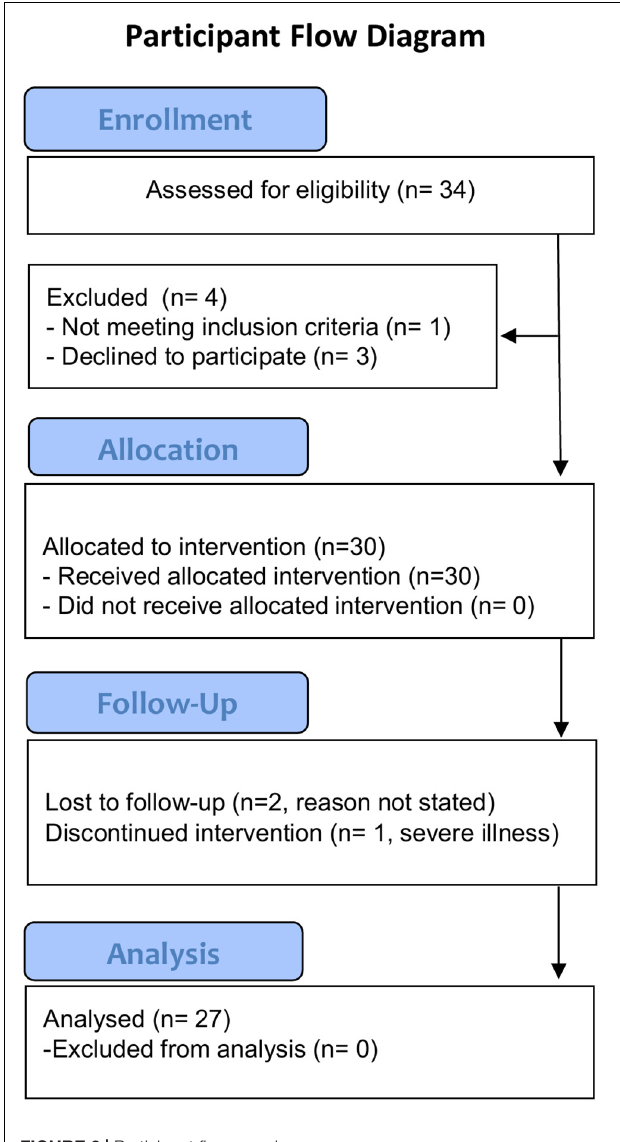
FIGURE 2 | Participant flow overview.